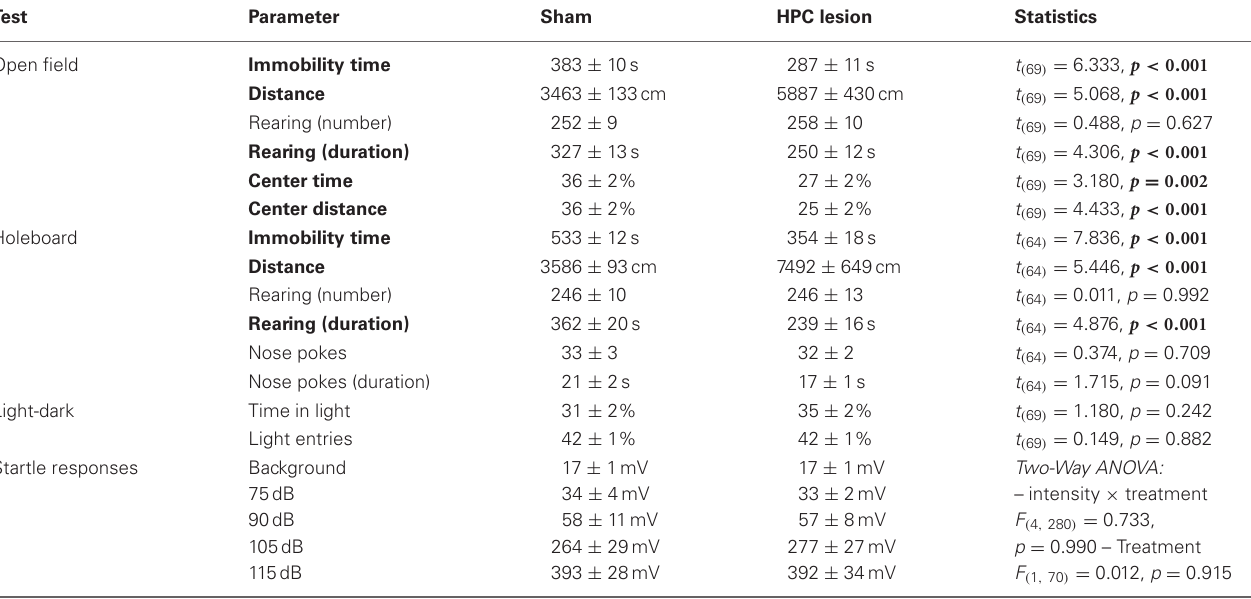
Table 1 | Consequences of HPC lesions on basic exploration and anxiety-related behavior.